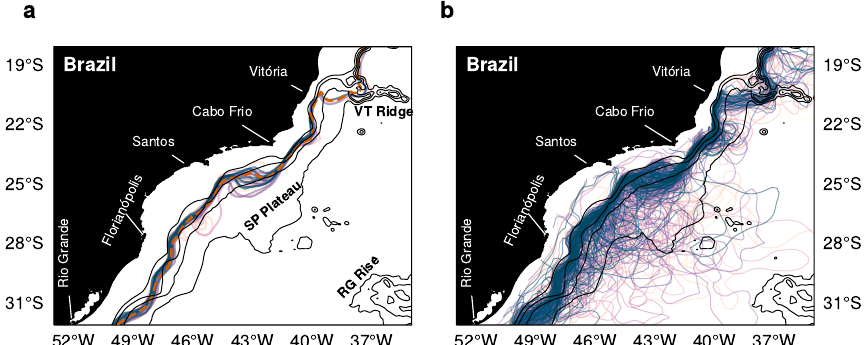
Figure 2. The Brazil Current front off Southeast and South Brazil as characterized by 28 years of satellite altimetry. ( a ) Yearly averaged fronts defined by 0.6-m contour of linearly detrended absolute dynamic topography ( h = 0.6 m); the orange dashed line is the long-term mean front ( MDT = 0.6 m). ( b ) Monthly averaged fronts defined by h (cid:48) = 0.05 m, where h (cid:48) is monthly averaged h (linearly detrended ADT ) subtracted from a regional mean. The colors represent time, ranging from begining to end of the altimetric record. The land annotations are coastal cities in Brazil, used for geographical reference in the text. Key topographic features are also marked: Vitória-Trindade (VT) Ridge, São Paulo (SP) Plateau, and Rio Grande (RG) Rise. Solid black lines depict the 200, 1000, 2000 and 3000-m